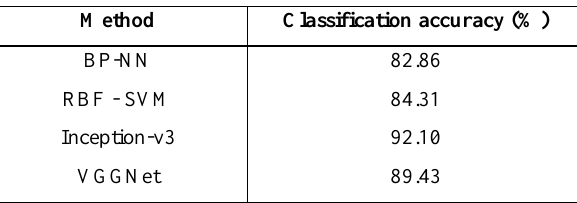
Table 1. Comparison of overall accuracies of Deep and shallow